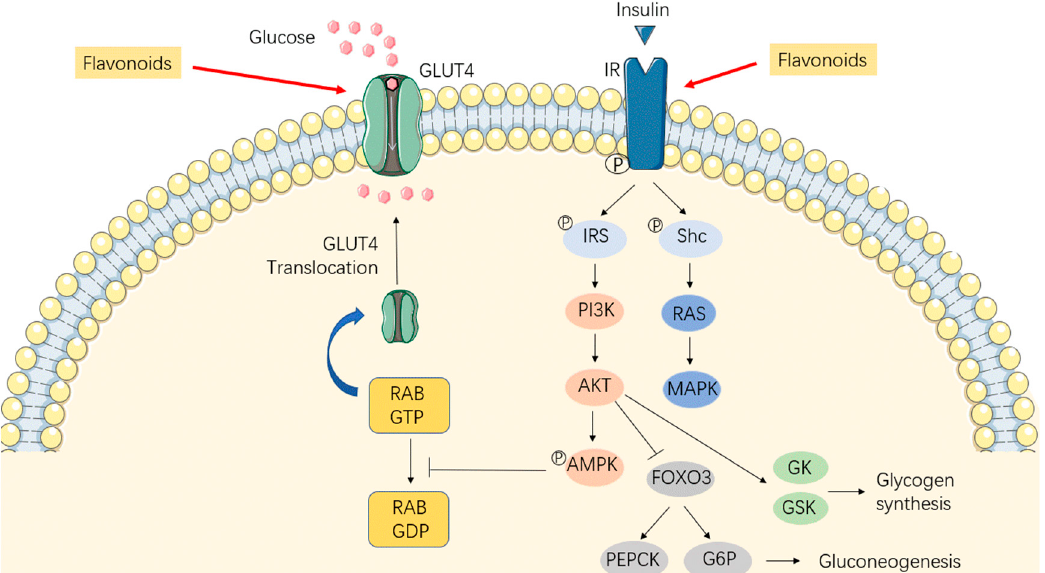
Figure 3. The potential mechanisms of how flavonoids intervene in insulin sensitivity. Flavonoids restore the phosphorylation of IRS and the activation of the PI3K/Akt pathway, which promotes the phosphorylation of AMPK and translocation of GLUT4 to the cell membrane, contributing to increased glucose uptake in the skeletal muscle and adipose tissue. In the liver, flavonoids inhibit gluconeogenesis and promote glycogen synthesis by improving the PI3K/Akt pathway. AMPK, AMP-activated protein kinase; AKT, protein kinase B; FOXO3, Forkhead box O3; GDP, guanosine diphosphate; GK, glucokinase; GLUT4, glucose transporter type 4; GSK, glycogen synthesis kinase; GTP, guanosine triphosphate; G6P, glucose 6-phosphate; IR, insulin receptor; IRS, insulin receptor substrate; MAPK, Mitogen-activated protein kinase; PI3K, phosphatidylinositol 3-kinases; PEPCK, phosphoenolpyruvate